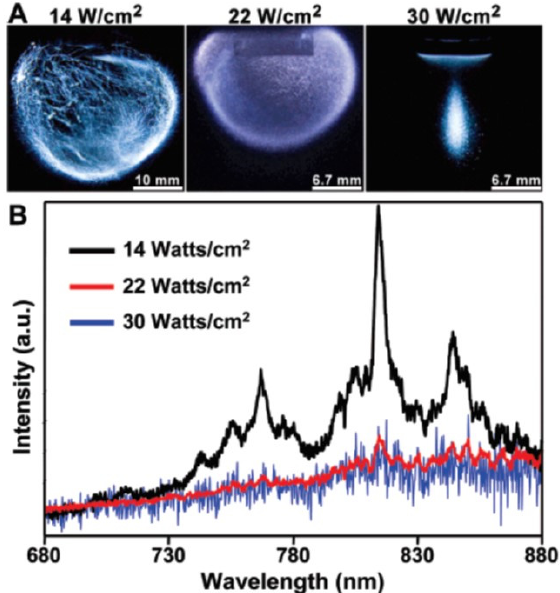
Figure 20. MBSL of concentrated H 2 SO 4 at different acoustic powers of an ultrasonic horn [55]. ( A ) Photographs (10 s exposures) of different light emitting regimes of MBSL of H 2 SO 4 , from left to right, with increasing acoustic intensity, filamentous, bulbous, and cone shaped emission; ( B ) MBSL spectra of concentrated H 2 SO 4 at the three acoustic intensities shown. As the acoustic power is increased, the Ar lines become weaker. Copyright 2007, with the permission from American Chemical Society.